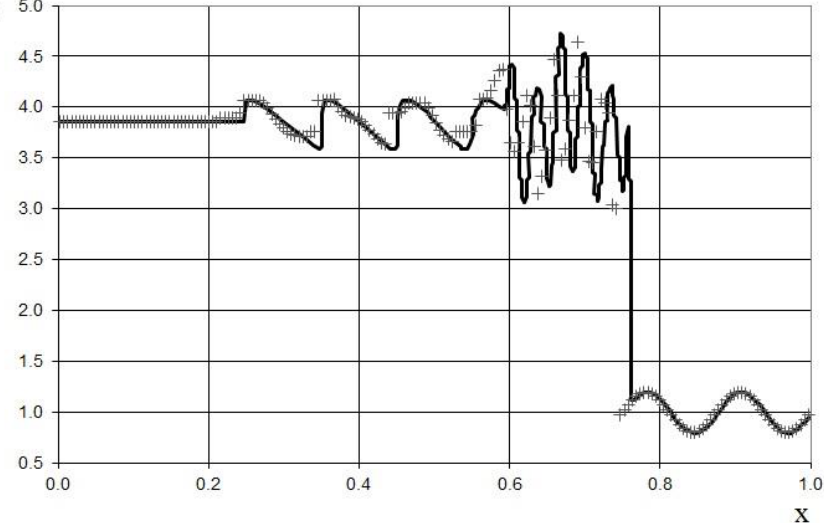
Figure 24. Density plot for the Shu – Osher shock-tube problem, using the fine grid (384 grid points): the “exact” solution [4 4] (line), and the present method (cross).